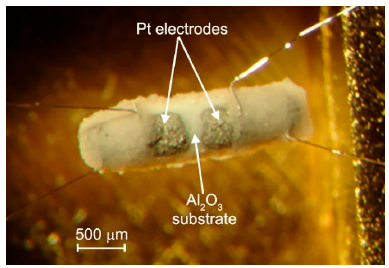
Figure 12. Optical image (top view) of the Al 2 O 3 substrate with Pt electrodes. The Pt heather is on the back side (not shown).